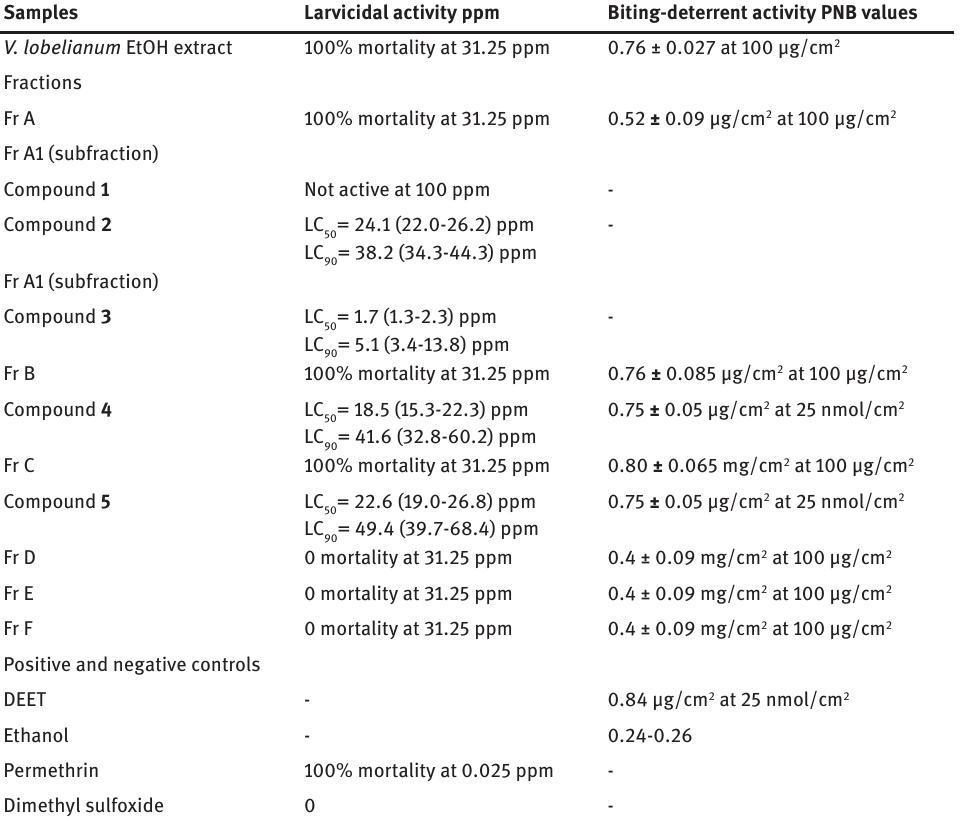
Table 2: Larvicidal and biting-deterrent activity of V. lobelianum extract, fractions and isolated compounds (1-5).